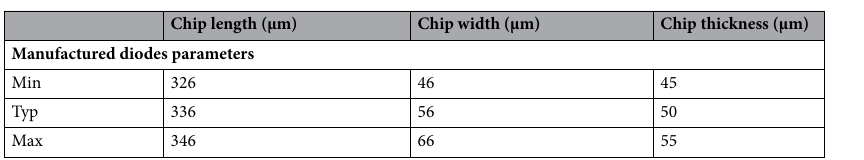
Table 2. Diodes parameters. Air-bridged Schottky diodes parameters including the dimensions of the chip and the diodes characteristic values as measured by the